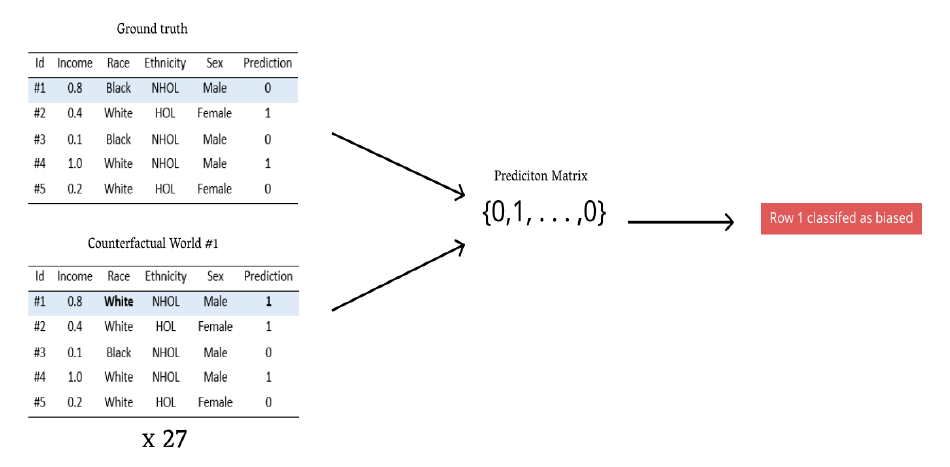
Figure 3. AWI bias classification procedure. (Note that only 2 counterfactual worlds are shown; however, a select data point will, for our use case, iterate over 27 counterfactual worlds. Bold indicates a change in parameters and results with respect to the ground